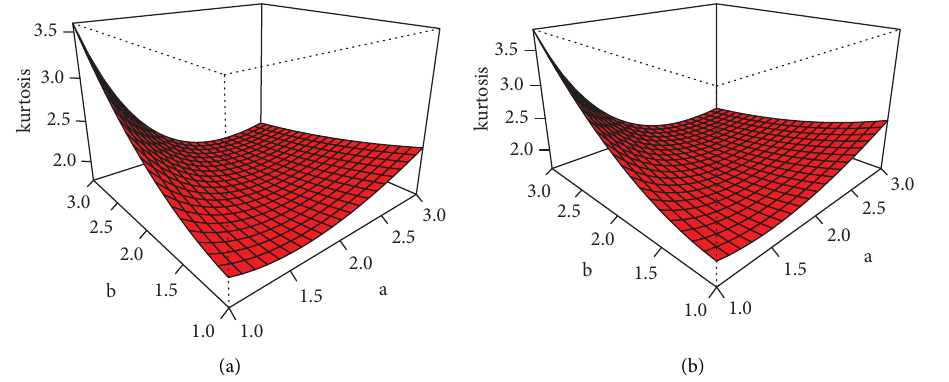
Figure 4: Plots of MKw kurtosis for some parametric